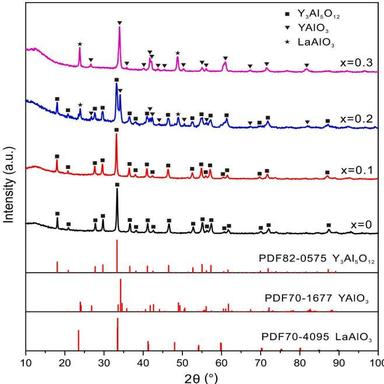
XRD patterns of (Y1-xLax)3Al5O12 (x = 0, 0.1, 0.2, 0.3) calcined powders.